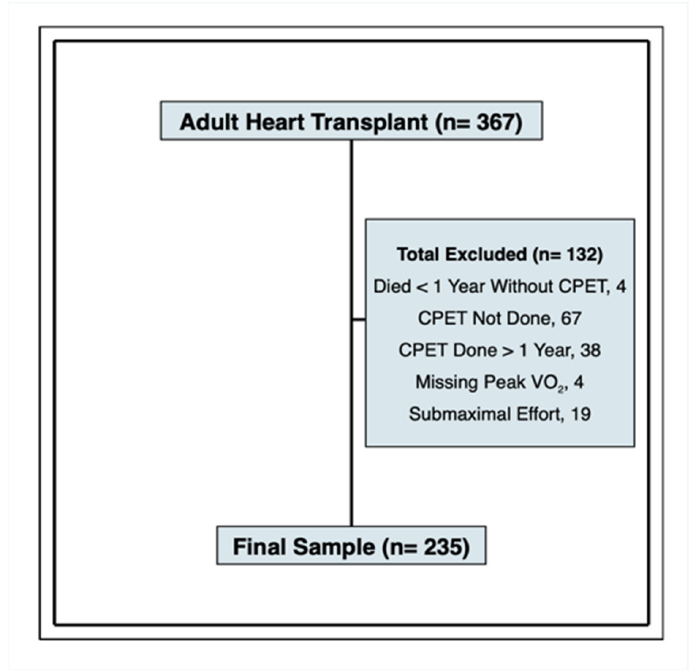
Figure 1. Study Inclusion and Exclusion. The final sample consists of 235 patients who had peak VO 2 measured within the first post-transplant year. Acronyms: CPET, cardiopulmonary exercise test; RER, respiratory exchange ratio.